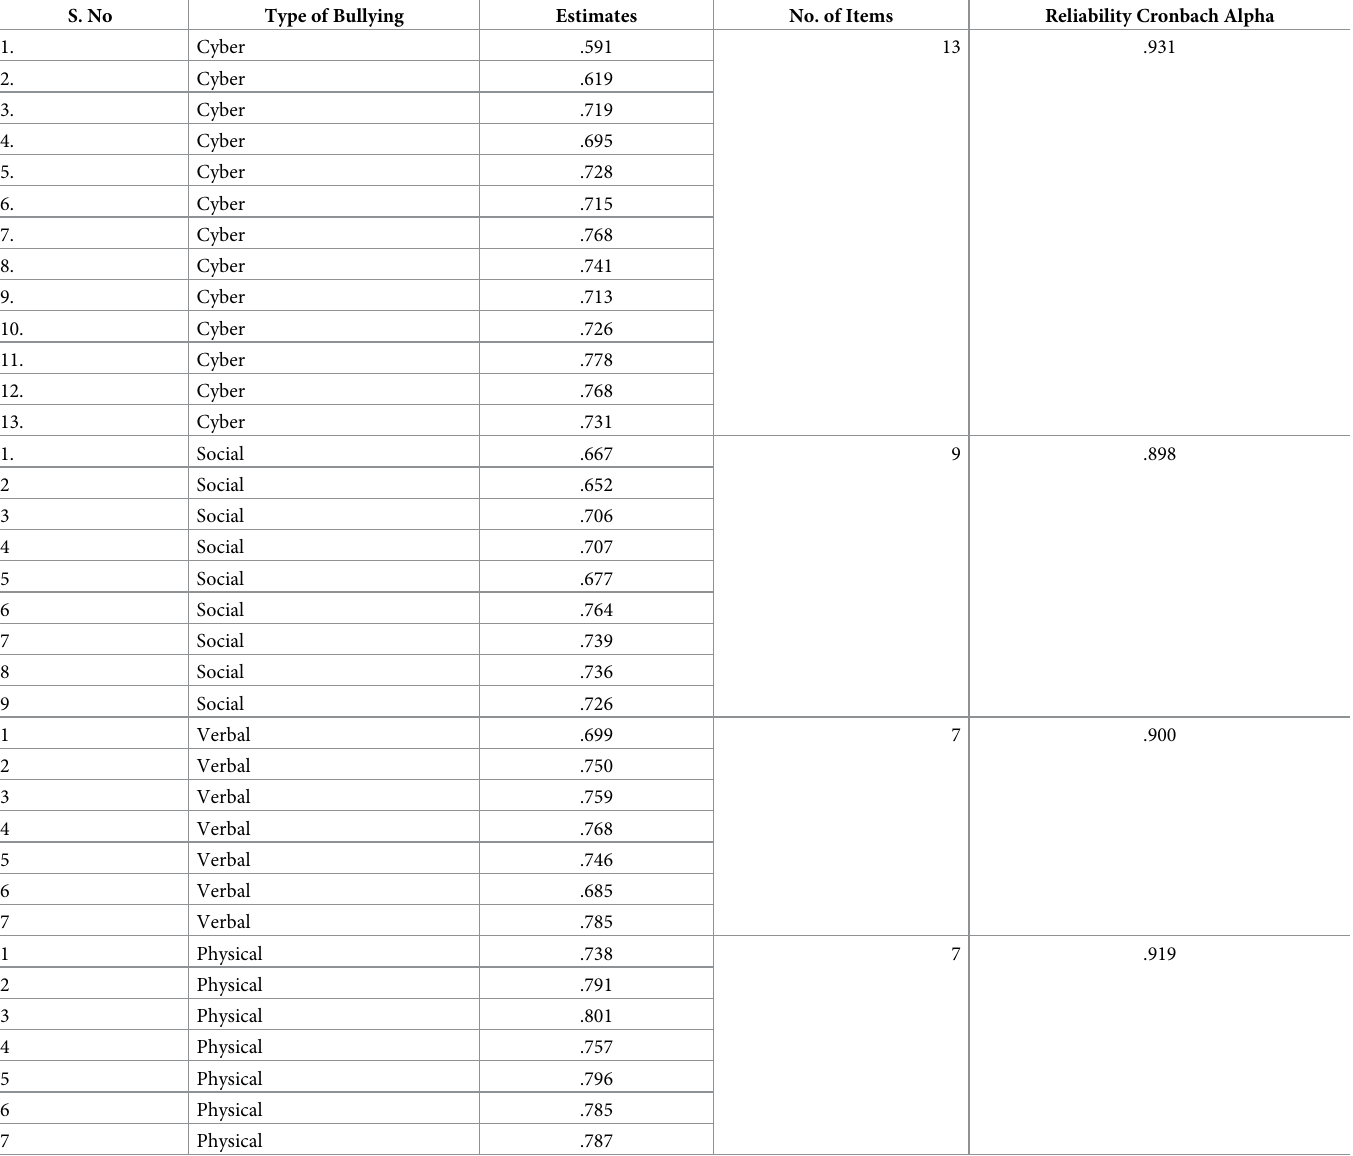
Table 2. Factor loadings and reliability